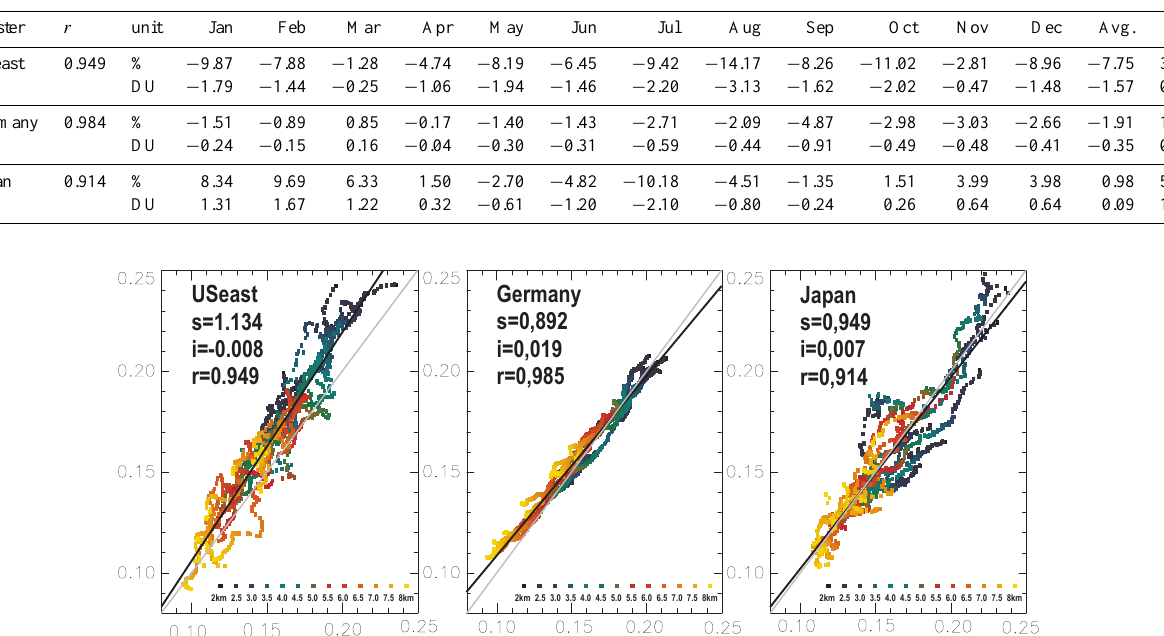
Table 3. Difference by month between the integrated content derived from MPTP ( O 3 ,z,m 0 ) and WPTP ( O 3 ,z,m 0 ) with z = [ 2 , 8km ] , in coincidence, for USeast, Germany and Japan clusters with the correlation coefficient r (column 2). The differences MPTP ( O 3 ,z,m 0 ) − WPTP ( O 3 ,z,m 0 ) are given in columns 4–15. The last two columns are the average and standard deviation. In each cell, the difference is expressed in percent and in DU on the first and second line, respectively.